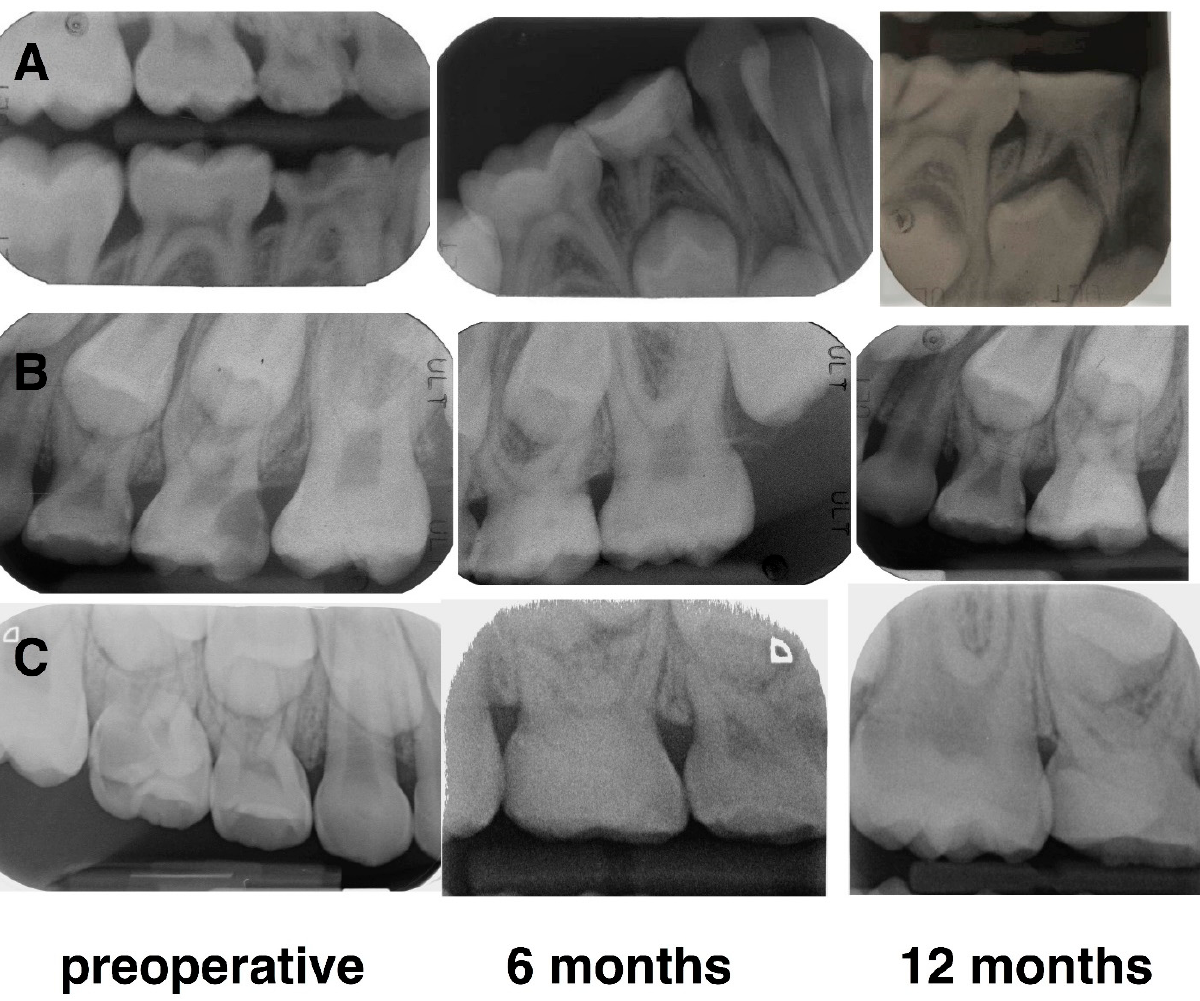
Figure 4. Radiographic images of successful pulpotomy of three primary molars at 6 and 12 months. Case ( A ): lower right first molar in stage S in a 6-year-old male; Case ( B ): upper left second molar in stage R in a 10-year-old female; Case ( C ): upper right second molar in stage S in a 6-year-old female.